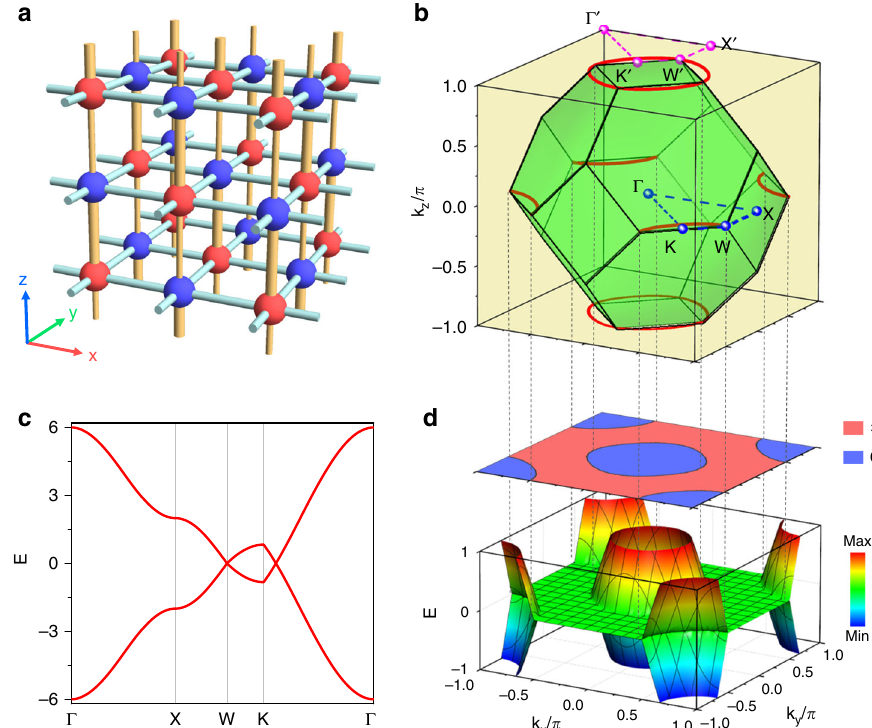
Fig. 1 Nodal rings and zero modes for an fcc lattice model. a Schematic of the tight-binding con fi guration for the fcc structure. Red and blue spheres indicate the inequivalent lattice sites, which share uniform hoppings in the x – y plain (blue rods) and possess unequal hoppings along the z direction (yellow rods). b Nodal rings (denoted by red curves) distributed in momentum space. The green truncated octahedron corresponds to the fi rst BZ in reciprocal space, where high symmetry points are marked. The high symmetry points with and without primes are differed by a reciprocal lattice vector. c Bulk dispersions in the k z = 0 plane. Two dispersions linearly cross when passing the nodal rings, which also occur along an equivalent path in the k z = π plane. d Upper panel: Zak phase distributions for the model. Lower panel: the associated drumhead surface dispersion at the boundaries in the z direction. The parameters for the model are t = 1 and δ t =